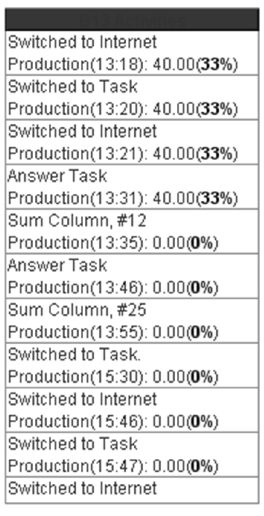
Figure 3. Monitoring screen with a zoom on Participant